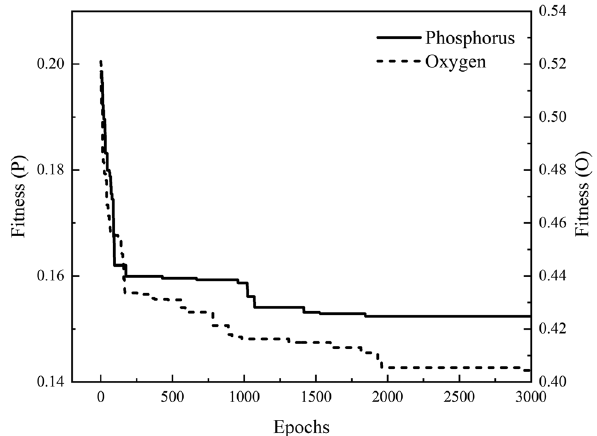
Figure 6: The error - epoch graph of GA – BP neural network.